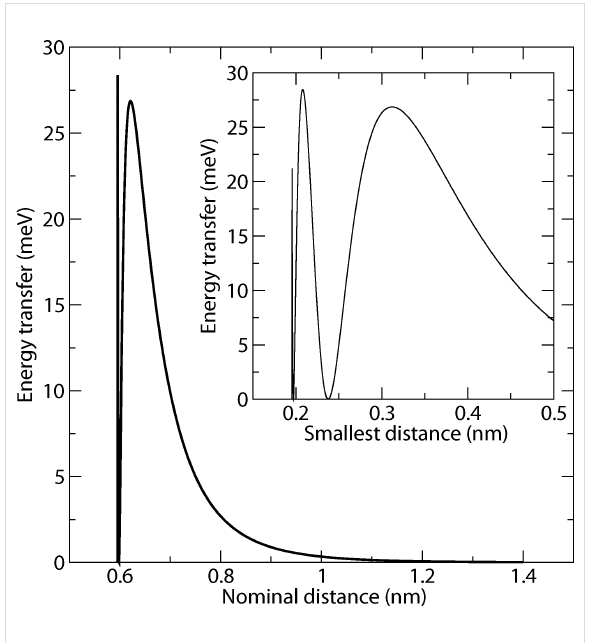
Figure 2: Distance-dependency of the energy transfer after one cycle. As a function of the nominal distance (which would be the closest ap- proach of the tip, if the interaction with the sample was switched off, cf. Figure 1), only one of the oscillations can be resolved. Due to the attraction between tip and sample the tip actually comes closer than the nominal distance. In the inset, which shows the same data, advan- tage has been taken of the non-linear dependence of the actual minimal distance on the nominal distance in order to resolve a second